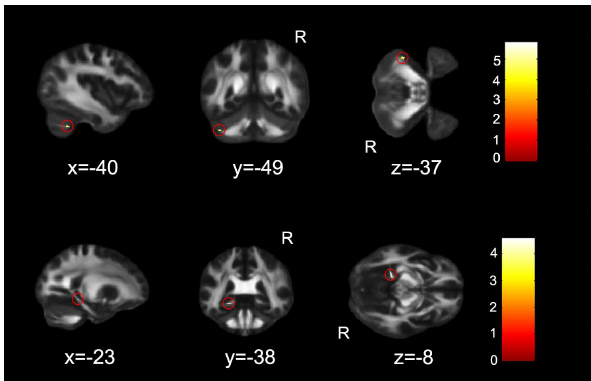
Figure 2. FA skeleton regions where alerting ratio scores showed a significant positive correlation with FA maps (p , 0.05, corrected). The region in red circle was identified as the left cerebellar Crus I and cingulum provided by FSL. The coordinates are in MNI standard space. R, right hemisphere.